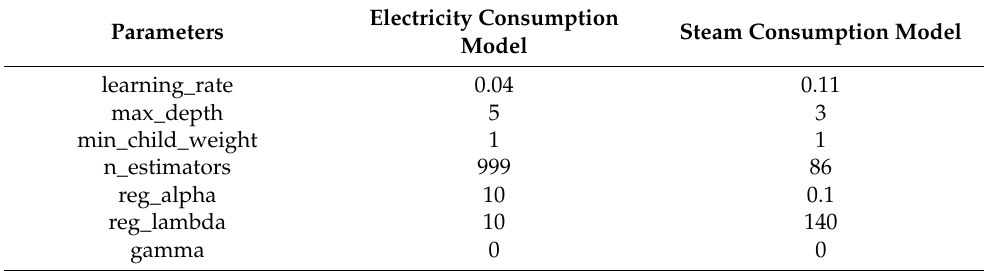
Table 5. The parameters for the electricity consumption model and the steam consumption model.